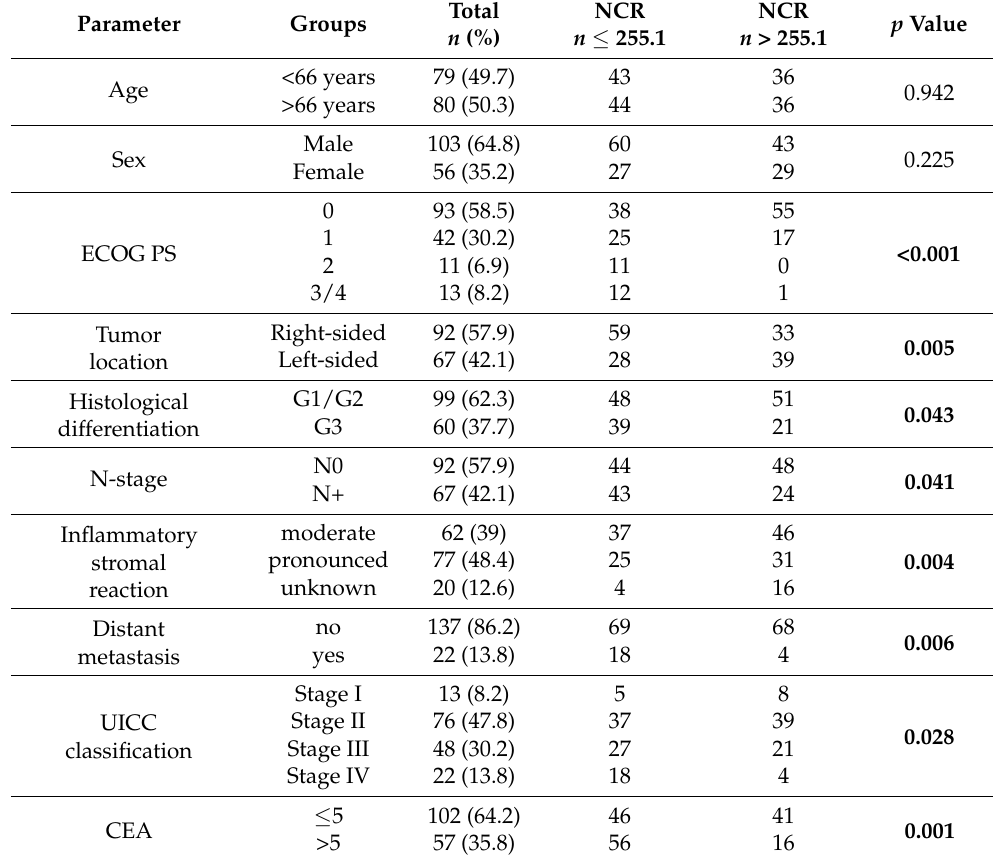
Table 4. The relationship between clinicopathological variables and NCR in patients with colon cancer in the discovery cohort. (ECOG PS: Eastern Cooperative Oncology Group performance status).